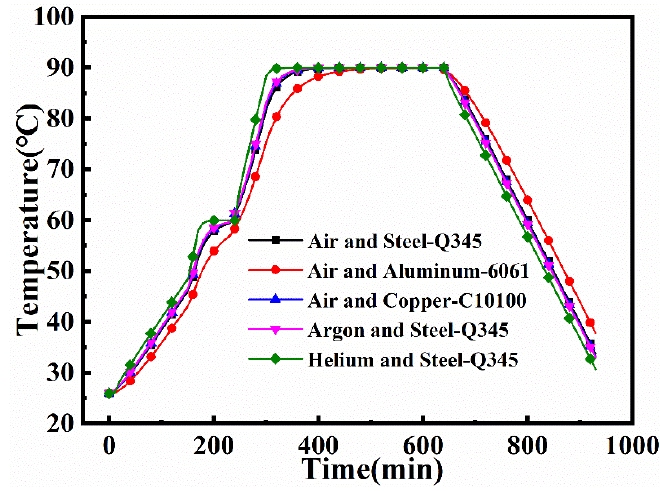
Figure 15. Average temperatures of the mold panel.